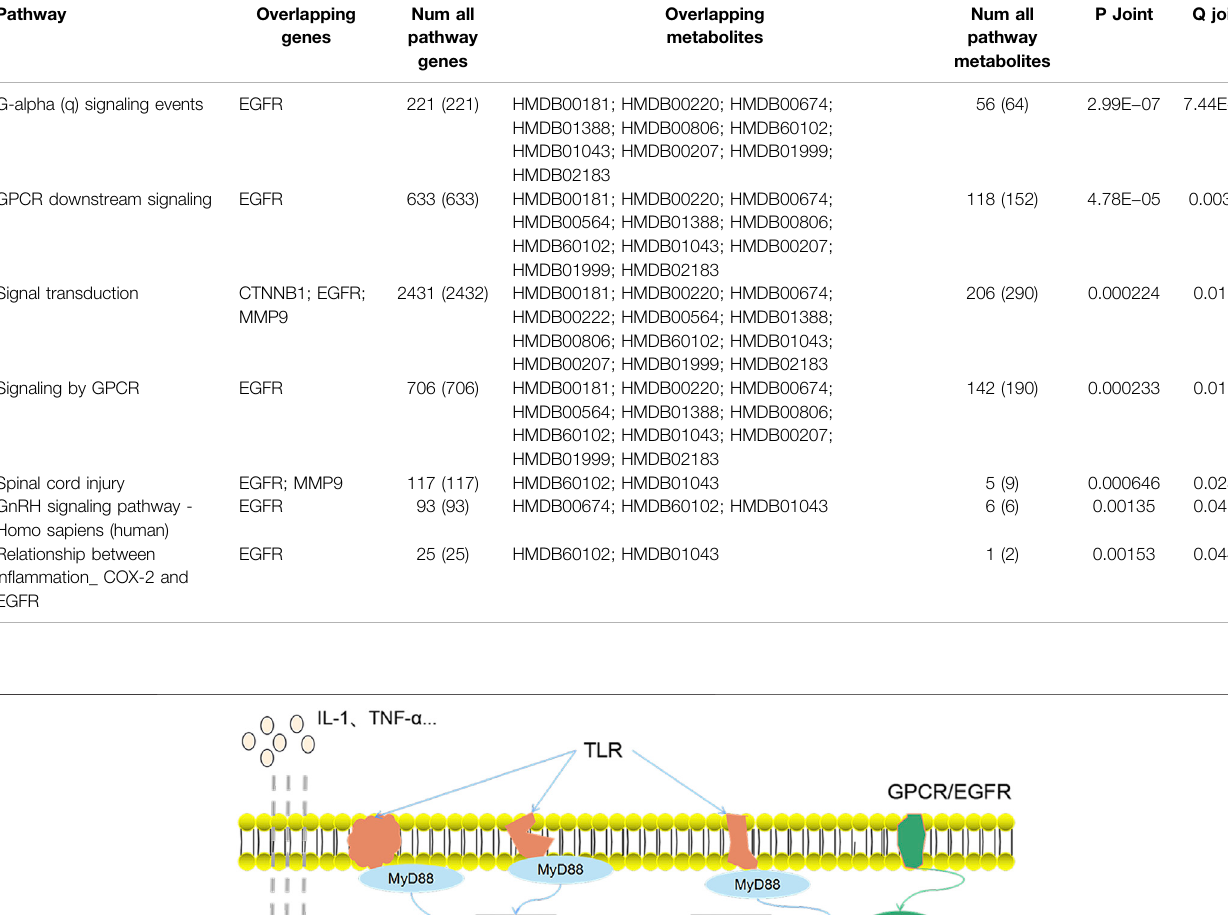
TABLE 4 | Enrichment analysis chart.